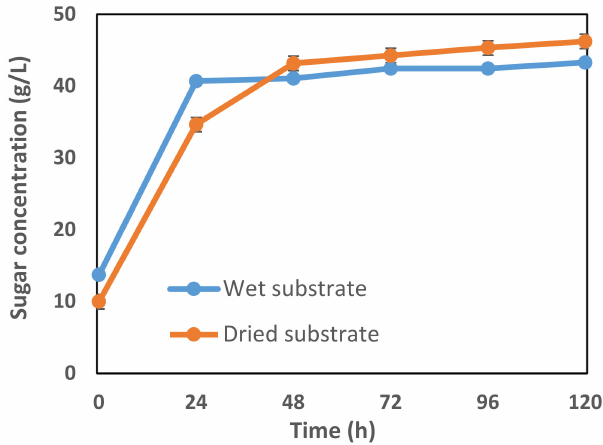
Figure 2. Effects of the wet and dried substrates used in the saccharification process of sago hampas by the mixture of amylase and